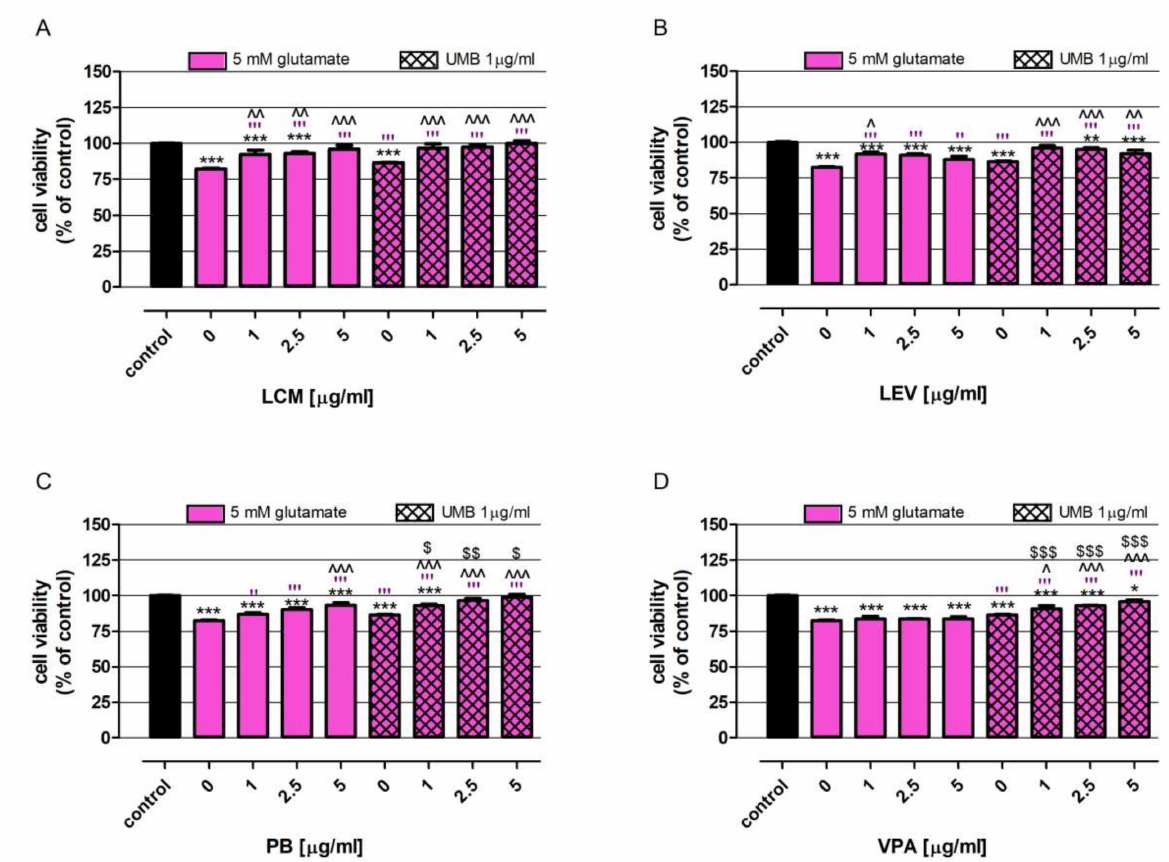
Figure 6. UMB impact on the biological activity of LCM ( A ), LEV ( B ), PB ( C ) and VPA ( D ) in neurons under glutamate excitotoxicity conditions. Neurons derived from human neuroblastoma cell line SH- SY5Y were exposed for 48 h to investigated drugs at concentrations 1, 2.5, and 5 µ g/mL in glutamate medium (5 mM glutamate), with or without 1 µ g/mL UMB. The control consisted of cells exposed to culture medium alone. Cell viability was measured photometrically using an MTT assay. Results are presented as the mean of at least 4 measurements. Statistically significant differences compared to the control at * p < 0.05, ** p < 0.01, *** p < 0.001; statistically significant differences compared to the UMB at ˆ p < 0.05, ˆˆ p < 0.01, ˆˆˆ p < 0.001; statistically significant differences compared to the glutamate medium at ” p < 0.01, ”’ p < 0.001; statistically significant differences between neurons treated with drug vs. neurons exposed to both UMB and drug at the corresponding concentrations at $ p <